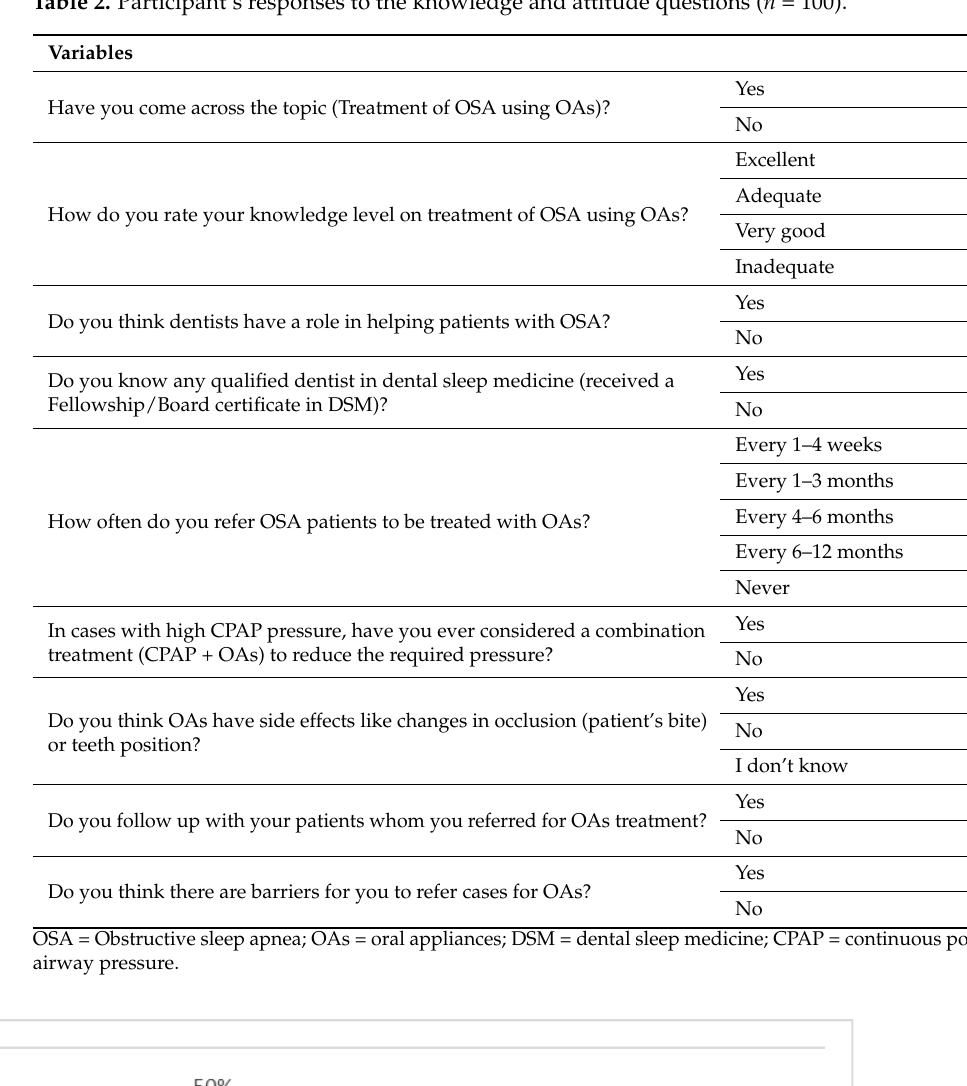
Table 2. Participant’s responses to the knowledge and attitude questions ( n = 100).